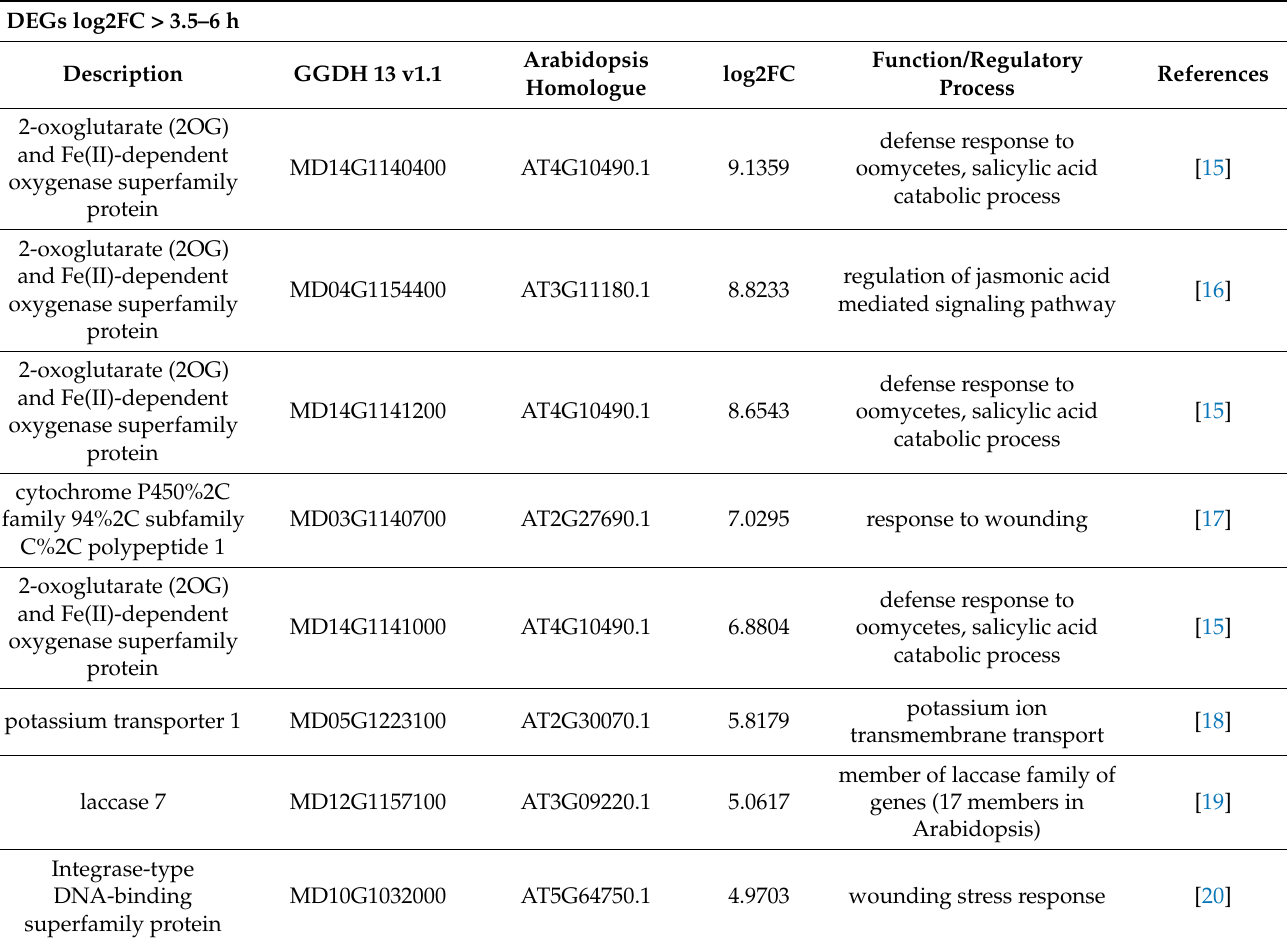
Table 1. Regulatory genes differentially expressed after 6 h of wounding and after 1 and 3 months of cold storage (only DEGs with a log2FC > |3.5| are listed). Columns from left to right report: description of the encoded protein, the corresponding Rosaceae database ID of the encoding gene, the closest Arabidopsis homologue, log2 fold change of transcript abundance found between wounded and control samples, putative functional/regulatory process played by the closest Arabidopsis homologue, and corresponding reference. The data refer to samples collected in